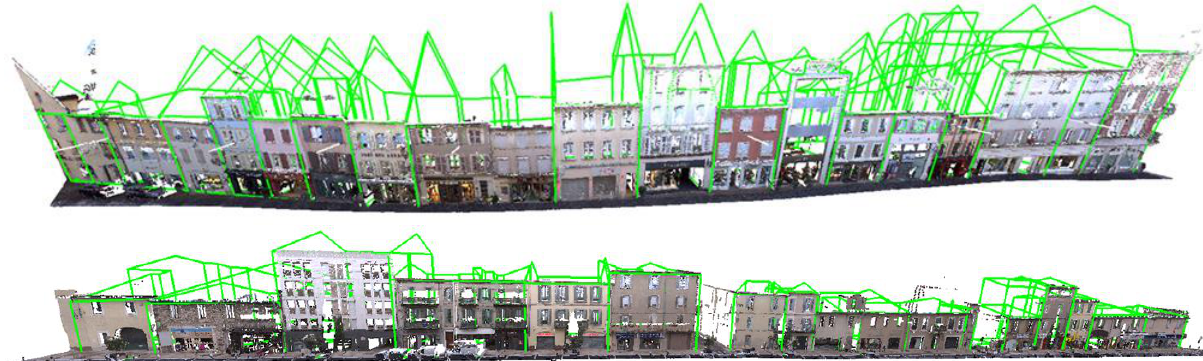
Figure 8: Datasets used for evaluating the method. Colorized point clouds and 3D polyhedral models are displayed. Top: Mulhouse “rue des boulangers”. Bottom: Nimes “rue de la république”.